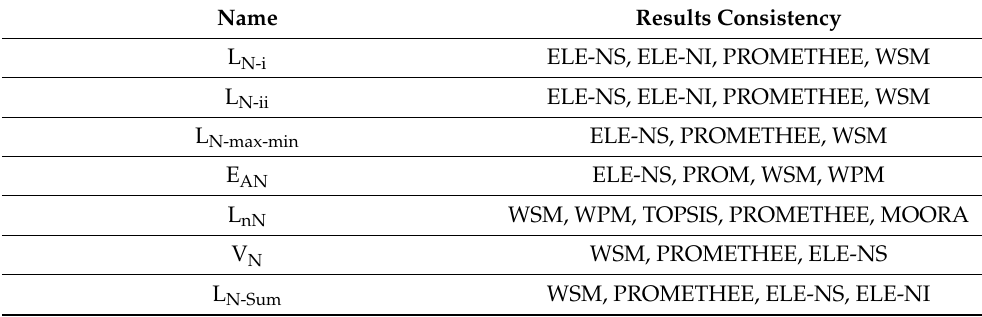
Table 5. Comparative analysis of normalization methods.